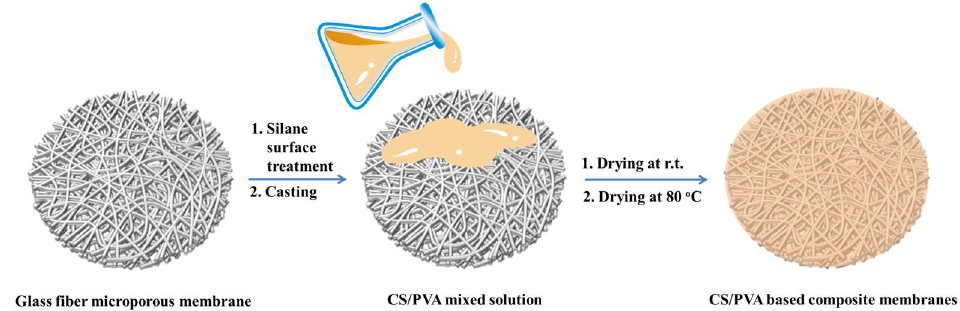
Figure 1. Illustration of the fabricating procedure for CS/PVA-based composite